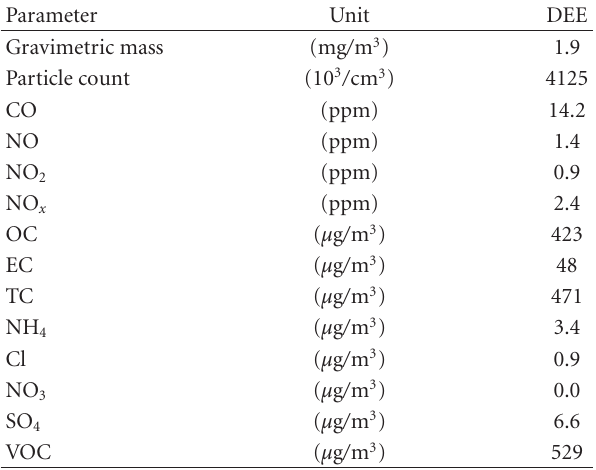
Table 1: Chemical composition and concentrations of diluted DEE.